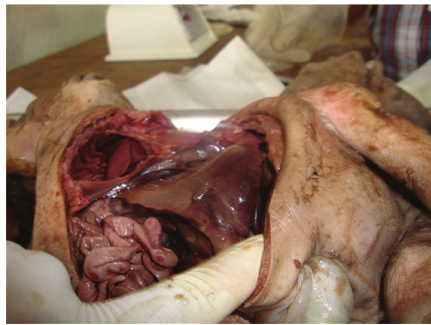
Figure 4: Abdominal cavity showing single